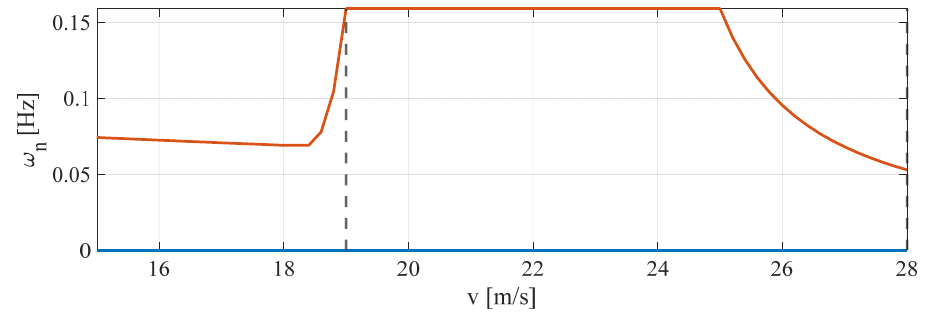
Figure 14. Pole migration of the gain-scheduled PID.